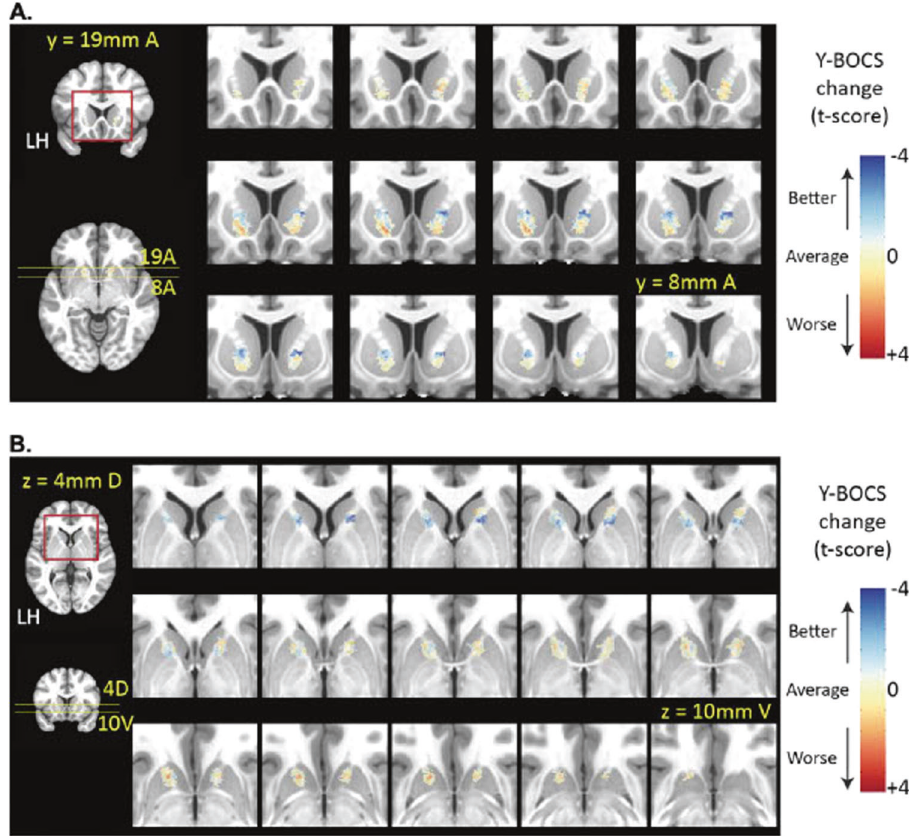
Fig. 4 Univariate lesion-symptom maps. A Coronal slices (magni fi ed view of the region in the red box) depict univariate lesion-symptom maps, with warmer colors depicting worse than the average change in Y-BOCS t -scores, and cooler colors depicting greater than average change. The axial slice shows the anterior-to-posterior extent of the coronal slices. Lesions including the dorsal region of the targeted area (near the middle third of the capsule) were associated with decreased OCD symptomatology as compared to lesions including the most ventral region of the capsule. LH: Left hemisphere. B Univariate lesion-symptom maps overlaid on axial slices on a 1 mm MNI template. Slices shown cover from 4 mm superior of AC/PC to 10 mm inferior (magni fi ed view of the region in the red box). Coronal slice shows the superior to the inferior extent of the axial montage. For each voxel, a t -test was conducted comparing change in Y-BOCS score between those with and without a lesion at that location. Blue indicates better than average change (lower Y-BOCS, negative t -scores); red indicates worse than average